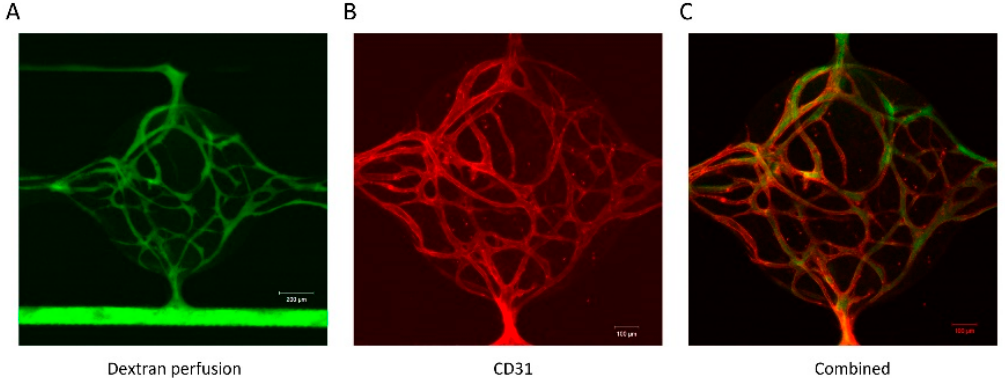
Figure 9. Vascular network formation in the microfluidic device using co-culture media. ( A ) Dextran perfusion through the vessel network. ( B ) CD31 staining of the vessel network. ( C ) Merged image from the dextran perfusion and CD31 staining.